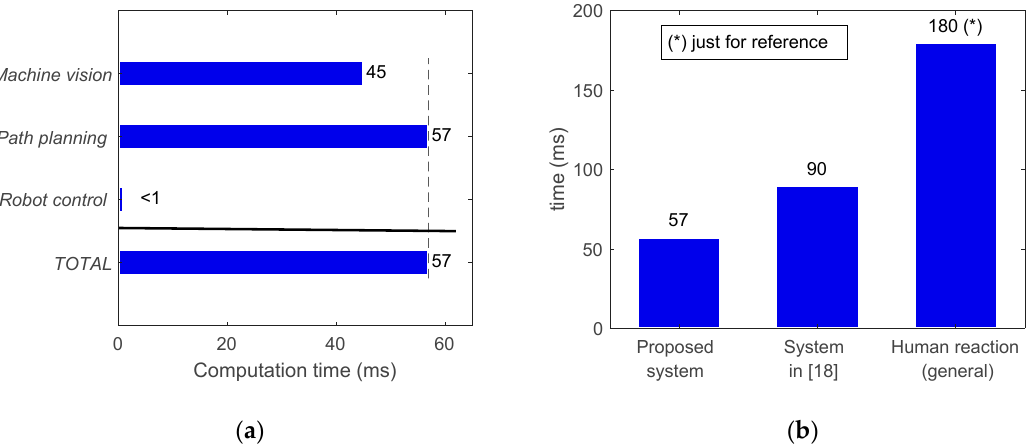
Figure 20. Approximated average computation times involved in: ( a ) Working cycle of the proposed system including machine vision, path planning and robot control modules running simultaneously (times do not accumulate); ( b ) Working cycle comparison between the proposed system and a different system developed in [20], including the human reaction time as a reference.